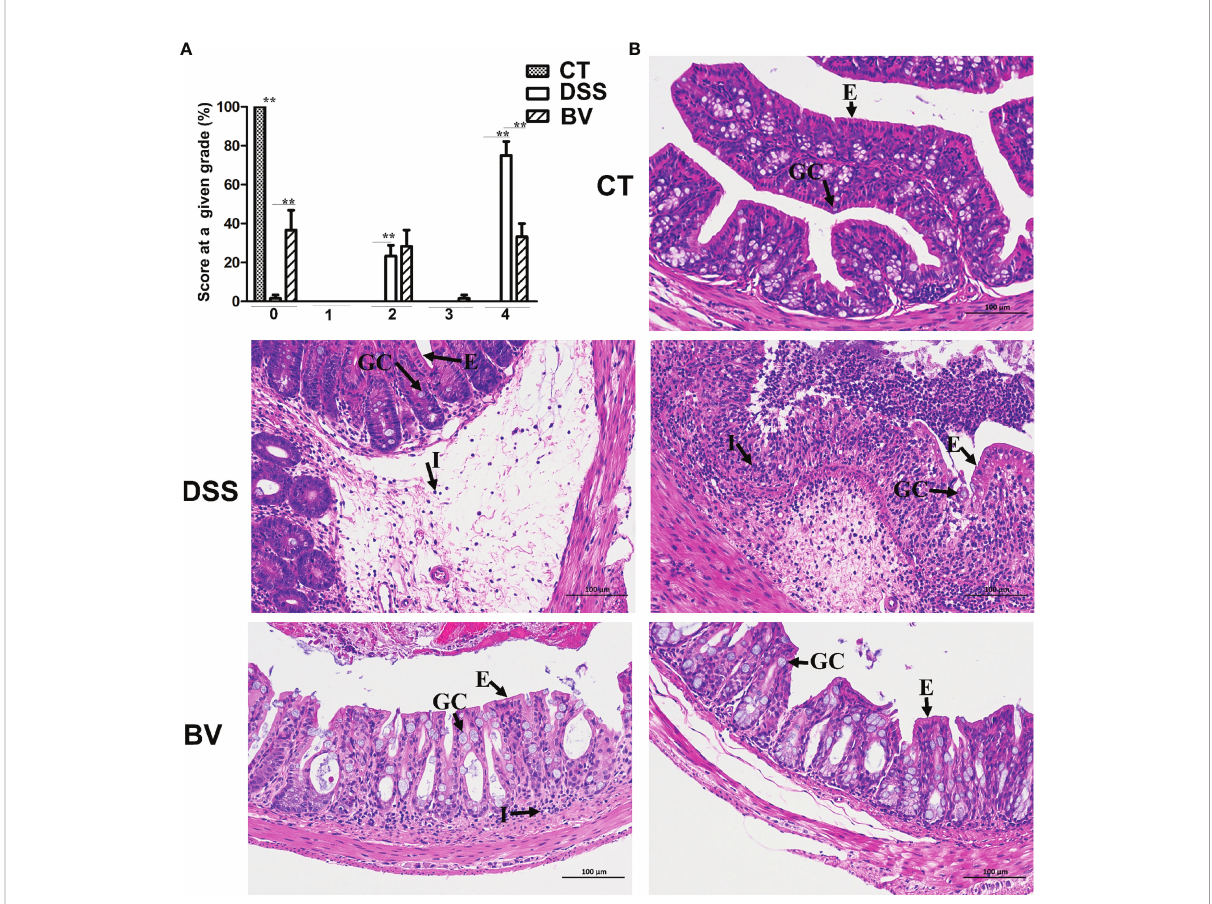
FIGURE 2 Histopathology of B. vulgatus Bv46 effect on acute DSS-induced colitis in C57BL/6J mice. (A) Histopathological scores. (B) Representative images of H&E stained sections of ascending colons from indicated groups; GC: goblet cell; E: epithelium; I: cellular in fi ltrate. CT, DSS, and BV denote control (no DSS induction), DSS induction and treatment with phosphate buffer saline only, and DSS induction and treatment with B. vulgatus Bv46, respectively. **, P <